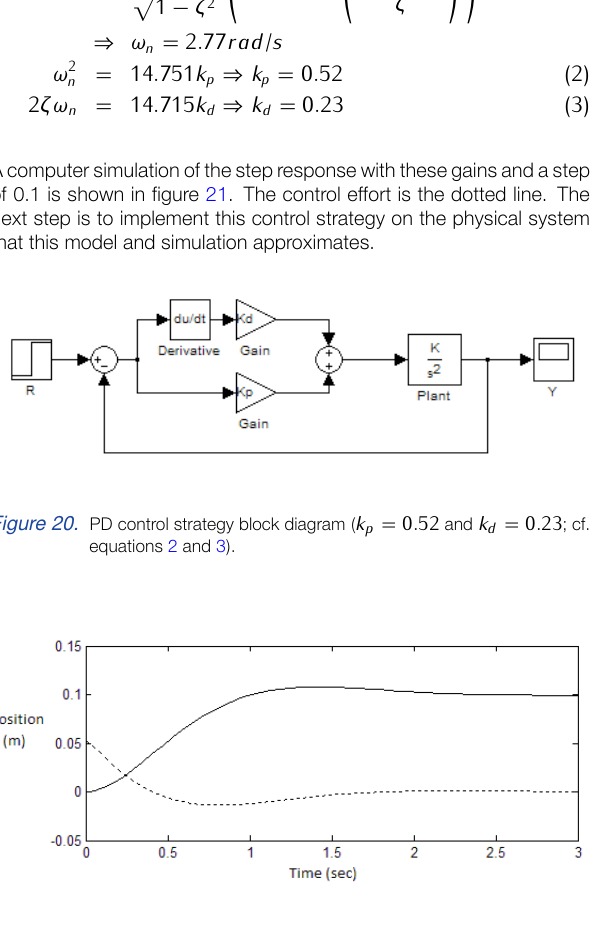
Figure 20: Simulated step response of the P‐D control Figure 21. Simulated step response of the PD control (cf. figure 20).